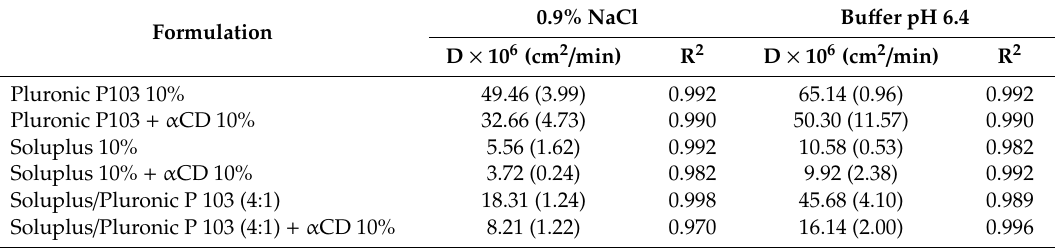
Table 4. Natamycin di ff usion coe ffi cients from Soluplus and Pluronic micelles, Soluplus:Pluronic P103 4:1 v / v mixed micelles, and poly(pseudo)rotaxanes in 0.9% NaCl and pH 6.4 bu ff er. Total copolymer concentration was 10% w / v . Mean values and, in parenthesis, standard deviation (n = 3). 0.9% Formulation